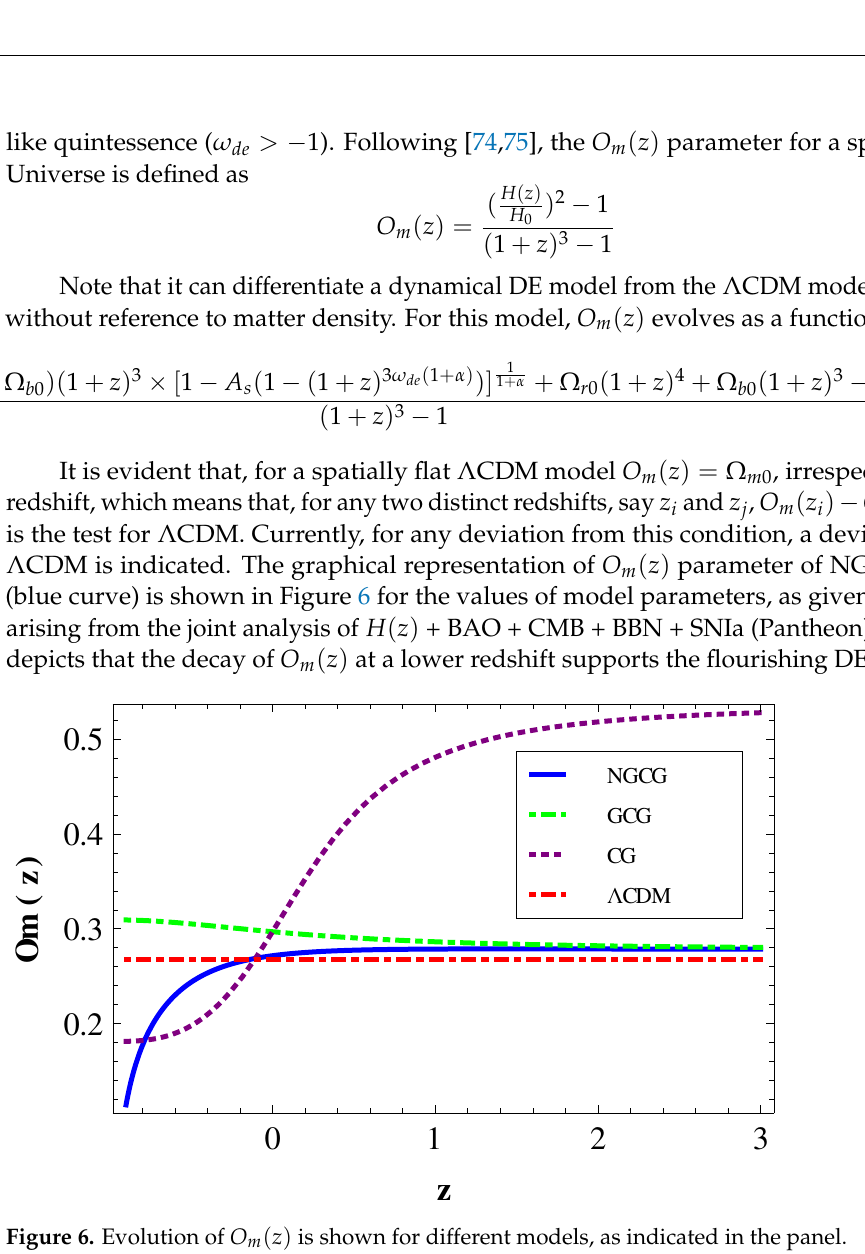
Figure 6. Evolution of O m ( z ) is shown for different models, as indicated in the